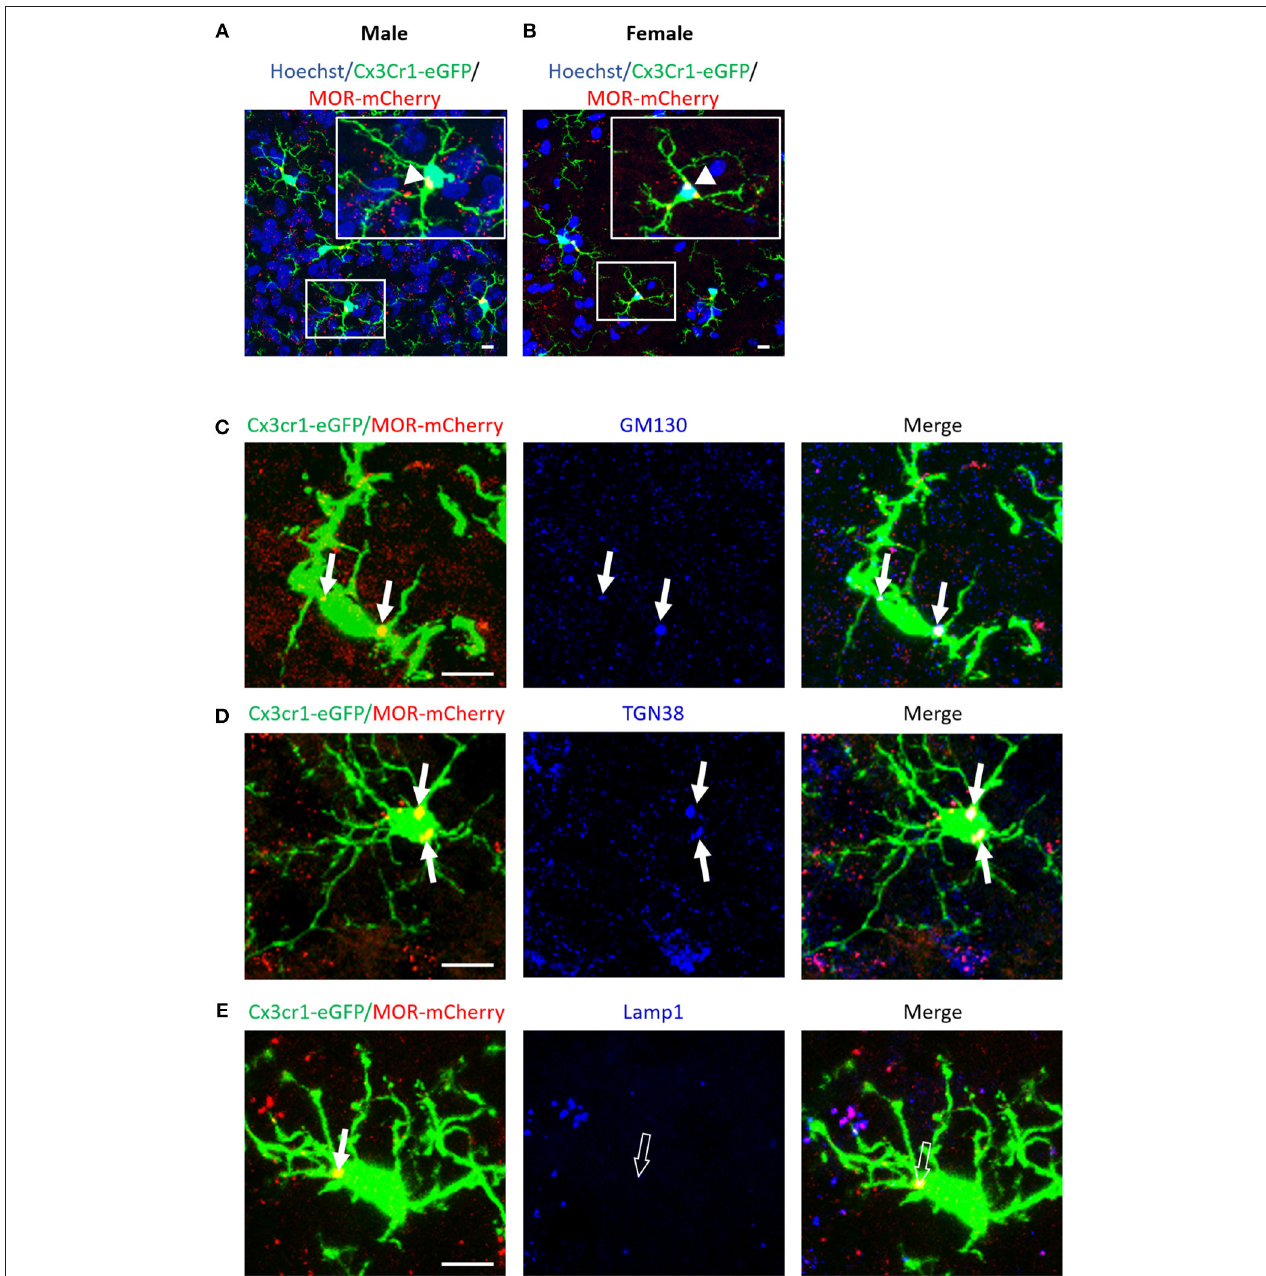
FIGURE 11 | MOR is expressed in microglia of the mouse spinal cord. (A,B) Photomicrographs from transverse sections of the lumbar spinal cord, at the level of the dorsal horn, demonstrate a colocalization (orange) of MOR-mCherry (red) with CX3CR1-eGFP-positive microglia (green) in adult male (A) and female (B) Cx3Cr1-eGFP-MOR-mCherry mice, indicated by white arrow heads. Scale bar = 10 µ m. (C–E) High magnification photomicrographs of CX3CR1-eGFP positive microglia (green) that colocalize (orange) with MOR-mCherry (red) are indicated with white arrows. Scale bar = 10 µ m. (C) Anti-GM130 labeling (blue) colocalizes (pink-white) with MOR-mCherry in the cis-Golgi of CX3CR1-eGFP positive microglia, indicated with white arrows. (D) Anti-TGN38 labeling (blue) colocalizes (pink-white) with MOR-mCherry in the trans-Golgi of CX3CR1-eGFP positive microglia, indicated with white arrows. (E) Anti-Lamp1 labeling (blue) of lysosomes does not colocalize with MOR-mCherry in CX3CR1-eGFP positive microglia, indicated with open arrows. The white (closed) arrow indicate colocalization of CX3CR1-eGFP with MOR-mCherry (orange) alone. suggested to result from synapse-related mRNAs that were from rodents. A significantly higher content of neuronal and phagocytosed by the microglia (19). The same phenomenon may astrocyte gene transcripts in FACS-isolated microglia compared to cultured microglia has already been reported, and was contribute to the positive correlation found between